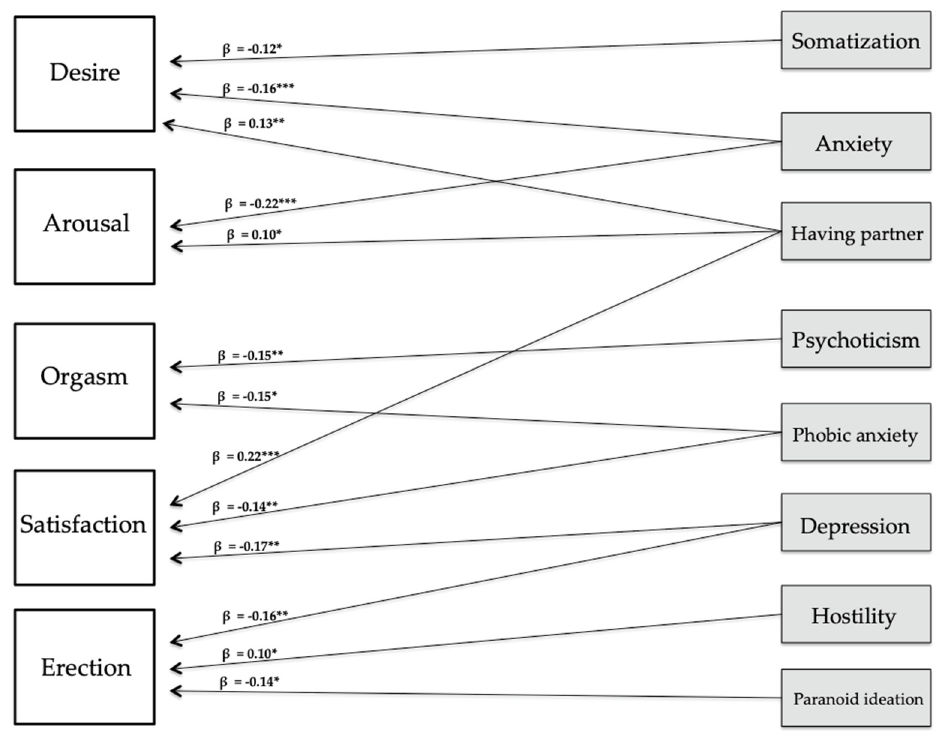
Figure 1. Graphical representation of the SEM in men. *** p < 0.001; ** p < 0.01; * p < 0.05.